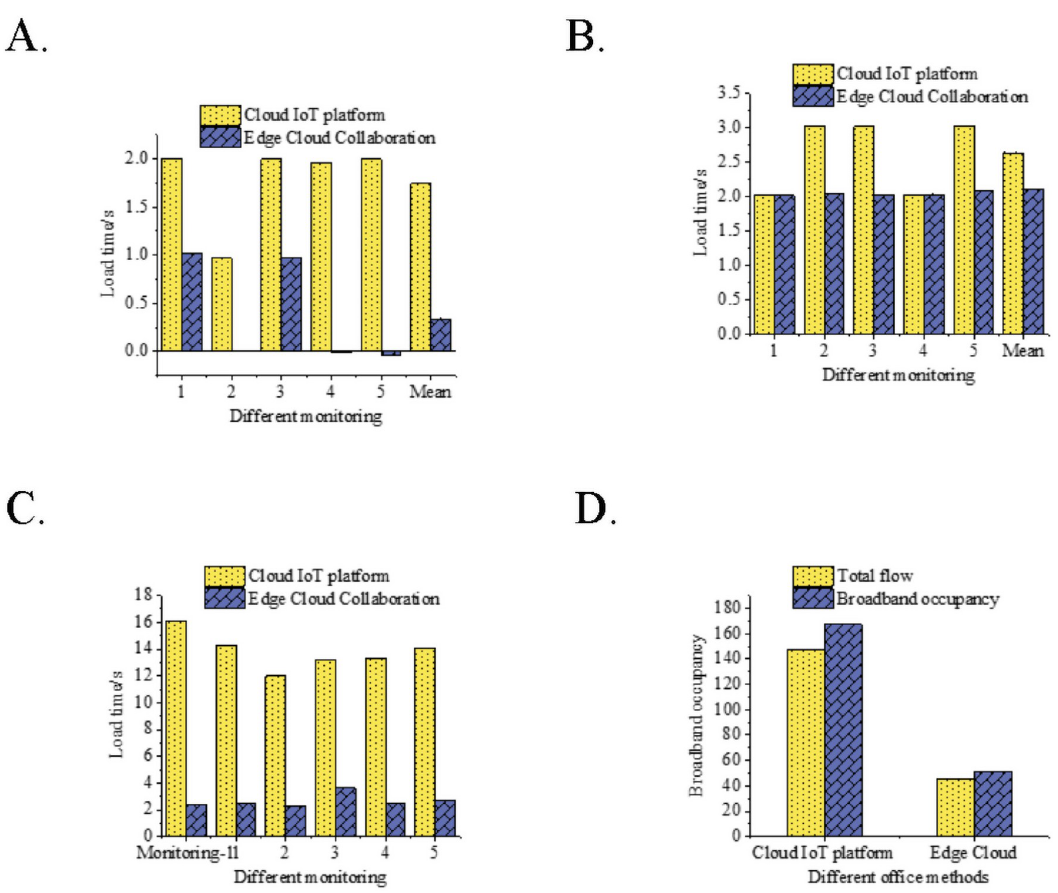
Fig 11. Effect analysis of the IoT analysis platform via edge-cloud collaboration. Note: Fig 11-A is the comparison of time- consuming between the cloud platform and edge-cloud collaborative platform. Fig 11-B shows the comparison of time-consuming between the cloud platform and edge-cloud collaborative platform in the case of 20 rules of single device. Fig 11-C represents the comparison of time-consuming between the cloud platform and edge-cloud collaborative platform in the case of large resource load. Fig D is the experimental results of bandwidth